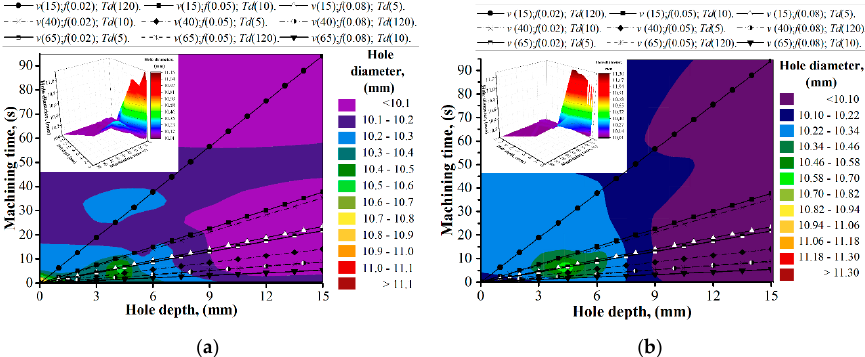
Figure 6. The hole diameter measures in hole No. 1. ( a ) Distribution of hole diameter under the conditions of the machining time and hole depth for hole No. 1; ( b ) distribution of the hole diameter in terms of machining time and hole depth for hole No. 5.